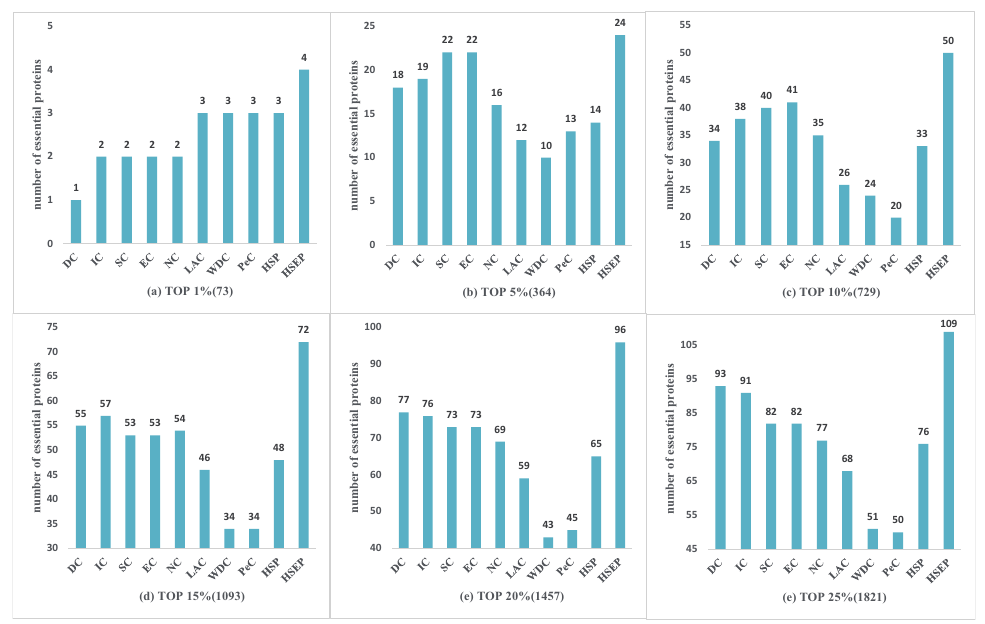
Figure 5. Comparison of HSEP with other essential protein discovery methods on HINT data. ( a ) TOP 1% (73); ( b ) TOP 5% (364); ( c ) TOP 10% (729); ( d ) TOP 15% (1093); ( e ) TOP 20% (1457); and ( f ) TOP 25%